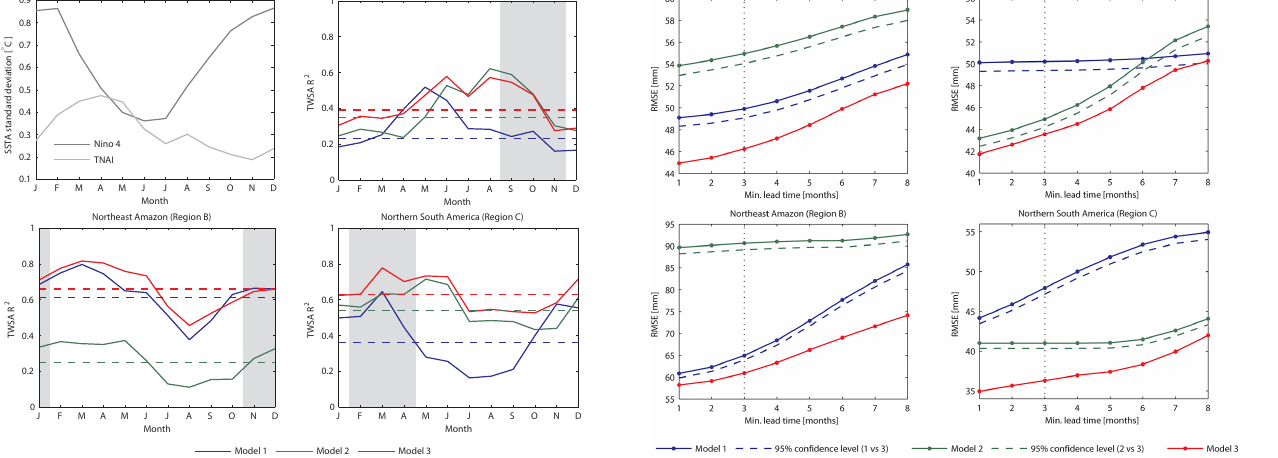
Figure 5. Top left subplot: the annual cycle of the standard devi- ation of SST-based climate indices (with no lags). Top right and bottom subplots: monthly climatology of R 2 between observed and predicted TWSAs averaged over each of the three regions delin- eated in Fig. 1a, for the three models described in Table 1 (with a 3-month prescribed minimum lead time). Dashed lines represent the R 2 computed for all months. The gray shaded areas represent the 3months with the lowest average TWSA, computed from the GRACE TWSA mean monthly climatology.